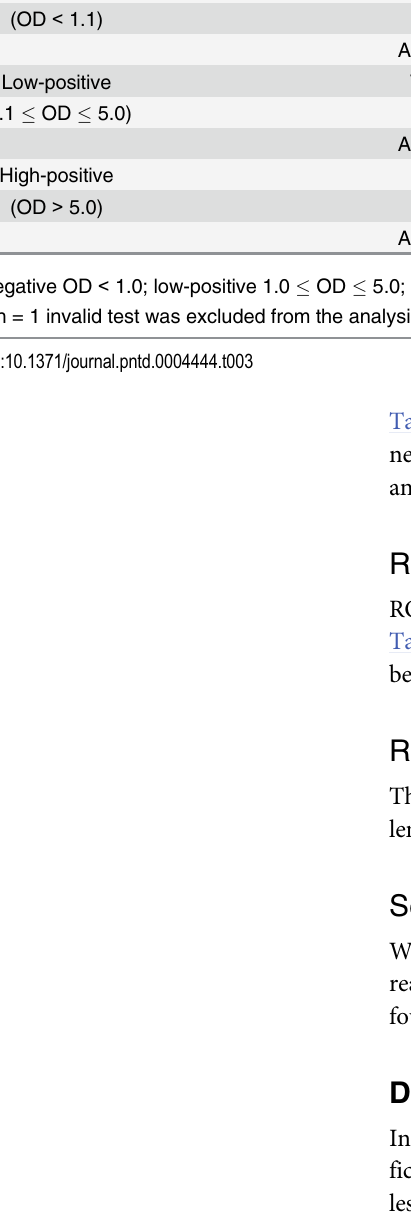
Table 3. Positive and negative results of RDTs stratified by ELISA OD values.